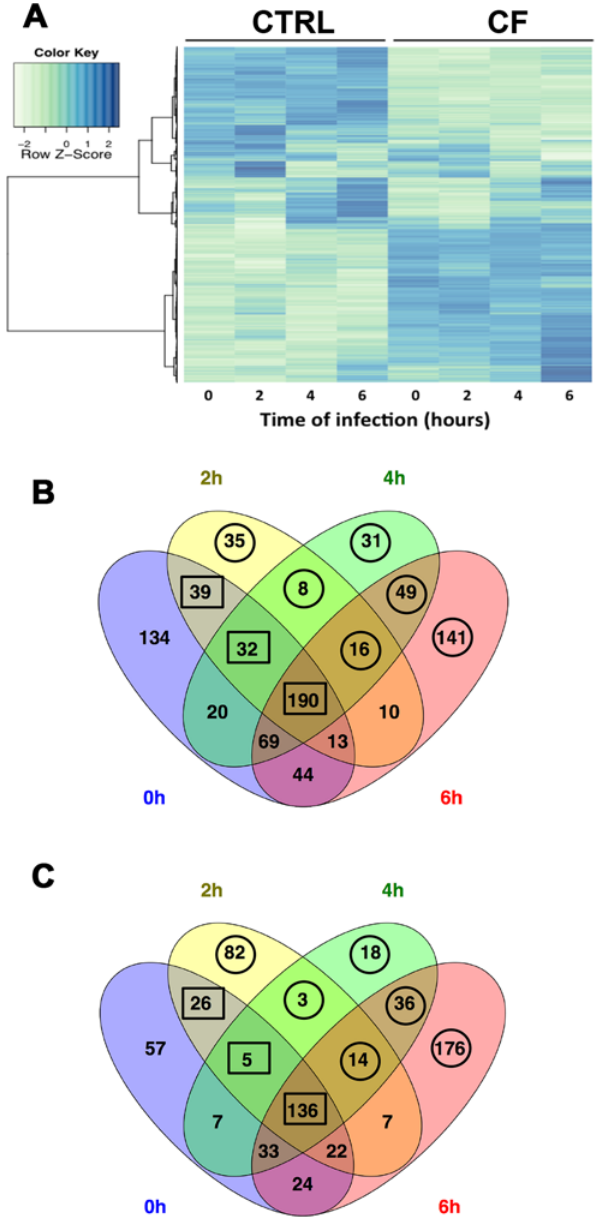
Fig 2. Overview of gene expression profiles. A- The heat-map of the mean expression levels of all the genes in each condition revealed two distinct clusters that separated cystic-fibrosis (CF) cells from CTRL cells. B and C- Venn diagram of differentially expressed genes between cystic-fibrosis and CTRL cells upon P . aeruginosa infection. Circles: Differentially expressed genes upregulated (B) or downregulated (C) at a single postinfection time point or at two or three consecutive postinfection time points (thus, 0h was not considered). We selected the genes whose fold-change in expression level was (cid:3) 2 in the event of upregulation and (cid:4) 0.5 in the event of downregulation. Squares: Differentially expressed genes upregulated (B) or downregulated (C) at two, three, or four consecutive time points (thus, 0h was considered). We selected the genes for which the ratio of FC in infected cells over FC in noninfected cells was (cid:3) 1.5 in the event of upregulation or (cid:4) 0.6 in the event of downregulation.